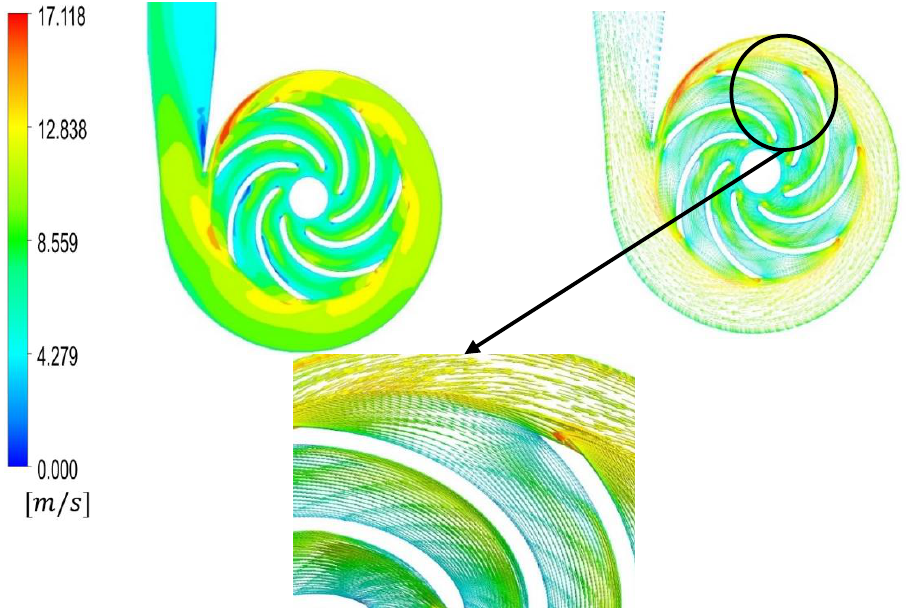
Figure 10. Velocity contours and velocity vector on a plane at 50% span location.